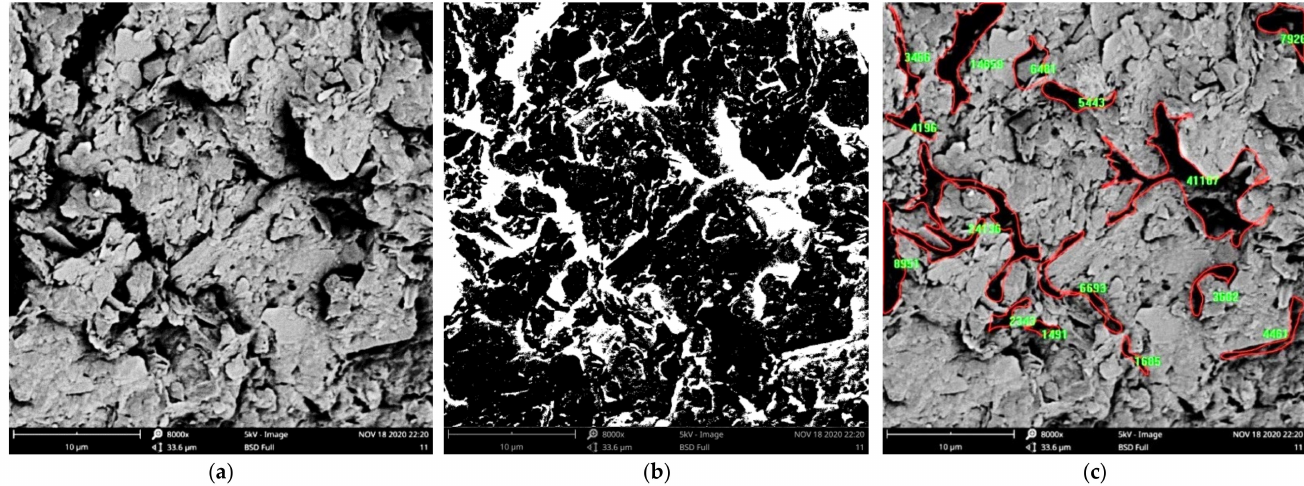
Figure 5. IPP software analysis process: ( a ) original image, ( b ) picture after binarization and ( c ) identifying the pore